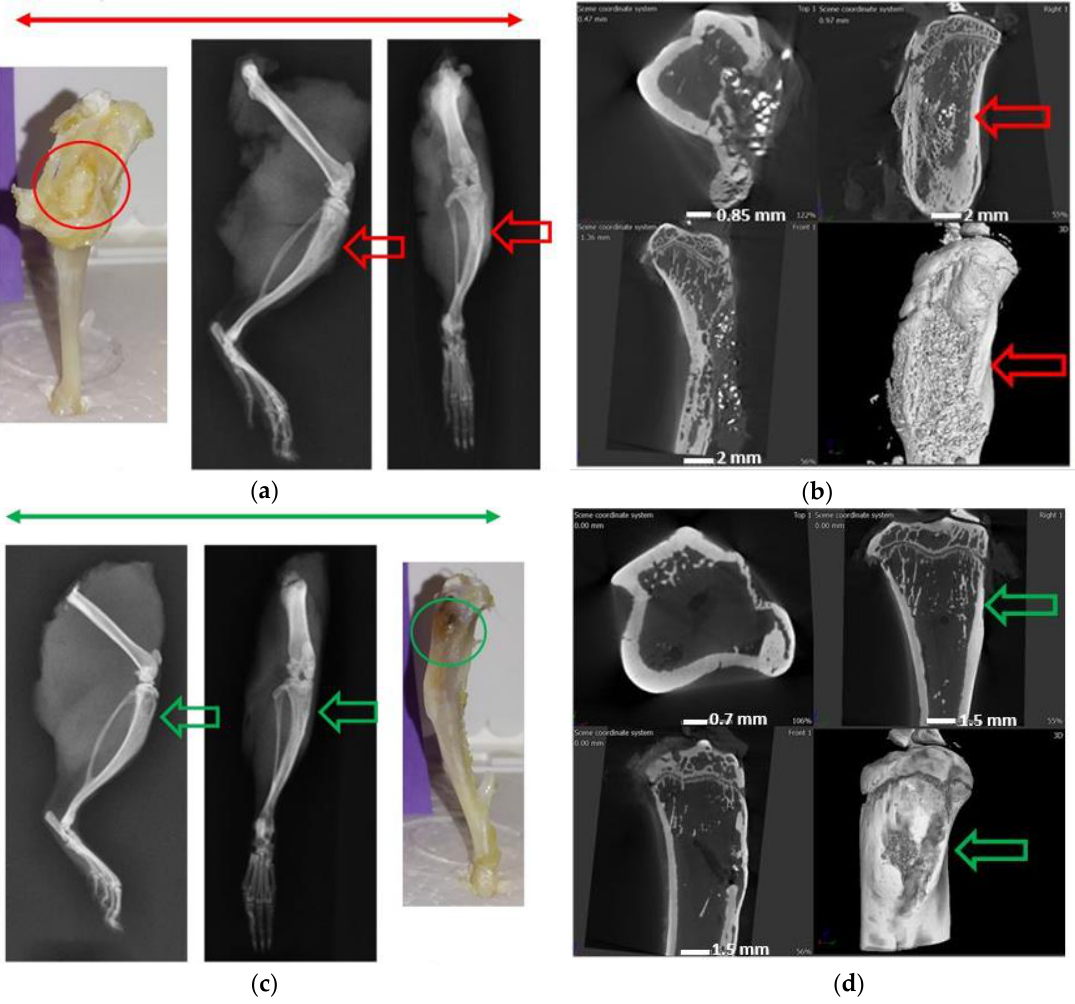
Figure 6. ( a ) Images under the red bar show the osteomyelitic bone in the infection control group. The macroscopic view (in red circle) and X-ray images (red arrow) show signs of osteomyelitis and sinus formation to drain the puss. ( b ) The μ-CT images show a deformed bone and narrowing of marrow space in this control group. ( c ) Images under the green bar show the treatment group animals with no apparent signs of osteomyelitis (green circle). ( d ) The µ -CT images show signs of bone healing and remodeling (green arrows).